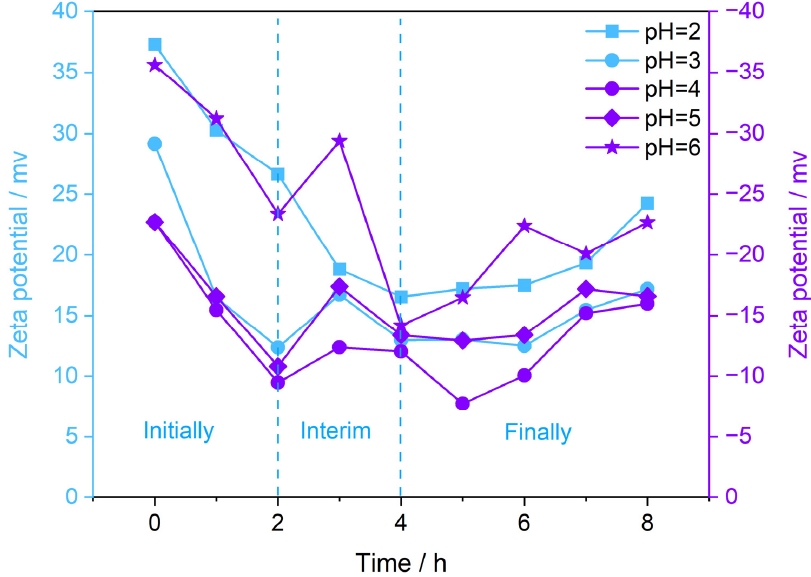
Figure 5. Influence of leaching agent pH on surface Zeta potential of rare earth particles during leaching.